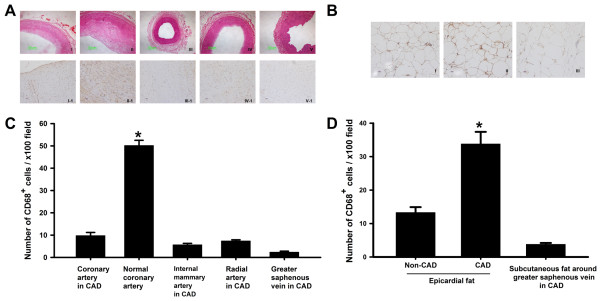
Histological studies on blood vessels and adipose tissues. (A) I: Normal coronary arteries presented intact endometrium and luminal patency; II: Atherosclerosis in the coronary artery, with a degree of stenosis of approximately 75%; III-IV: Internal mammary artery and radial artery from CAD patients, both showing intact endometrium and luminal patency, respectively; V: Greater saphenous vein from CAD patients presented luminal patency; I-1:Endothelial cells were intact, SCMs and fibers of intercellular layer are orderly arranged, and scarcely any CD68+ cells were observed in the adventitia; II-1: Large amounts of CD68+ cells infiltrated the adventitia in coronary atherosclerosis, which formed an accumulation zone; III-1~Ⅴ-1:Internal mammary artery, radial artery and greater saphenous vein were present, respectively, and obvious infiltration of CD68+ cells was not observed in the adventitia of each group. I-1~Ⅴ-1 immunohistochemical staining corresponding to the tissue stained by H&E. (B) The quantity of CD68+ cells infiltrated into epicardial adipose tissue in CAD was significantly increased. The bar charts were showing the number of CD68+ cells per ×100 field in each section of blood vessels (C) and adipose tissues (D), respectively. Date represented the analysis of minimum of 8 random sections per sample. Values are mean ± SEM. *P < 0.05 vs normal coronary artery in C and epicardial adipose tissue in non-CAD patients and subcutaneous fat around greater saphenous vein in CAD patients in D. Abbreviations: CAD, coronary artery disease; SMCs, smooth muscle cells.